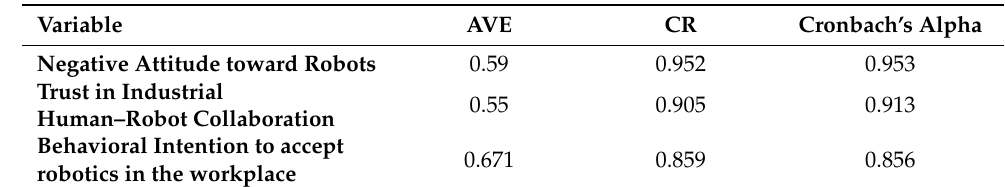
Table 4. Validity and Reliability.